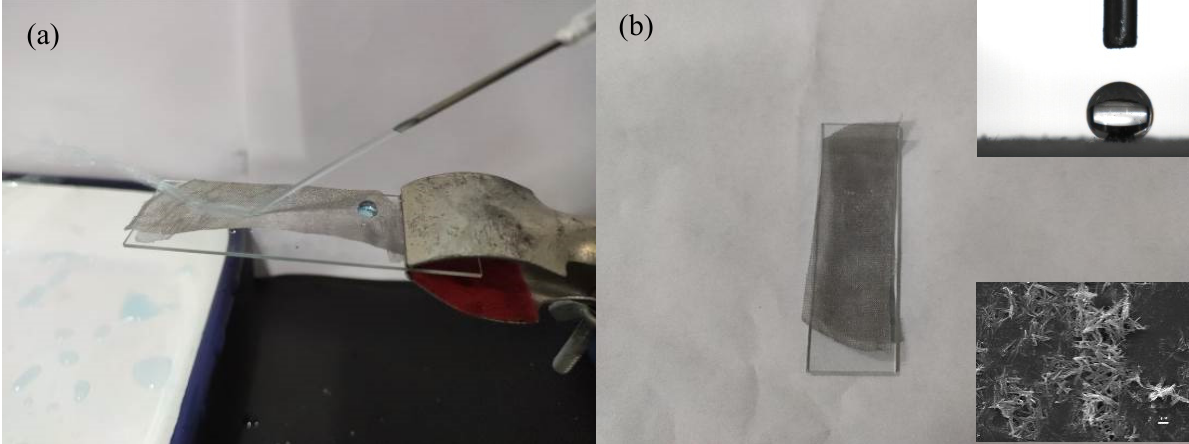
Figure 9. Test of water jet stability for the coated mesh: ( a ) During water jet progress; ( b ) The appearance after 10 min water jet test. The inserted SEM image shows the microstructure of the super-hydrophobic coating after the test. The upper right inset is the optical photograph for the water contact angle measurement after the water jet test.